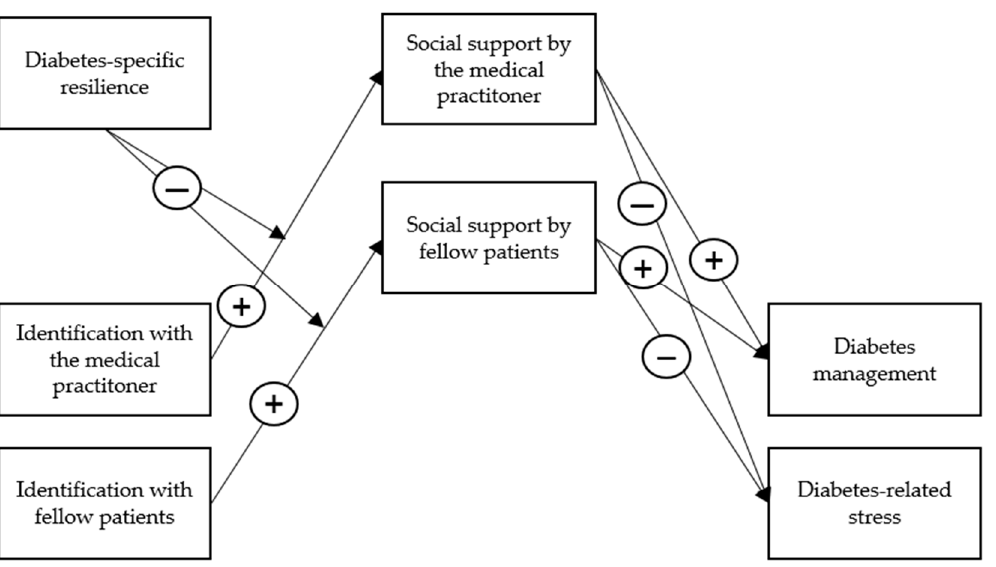
Figure 1. Overall research model. Identification with fellow patients and the medical practitioner and diabetes-specific resilience are measured at Time 1; all other variables are measured at Time 2 (4 weeks later).